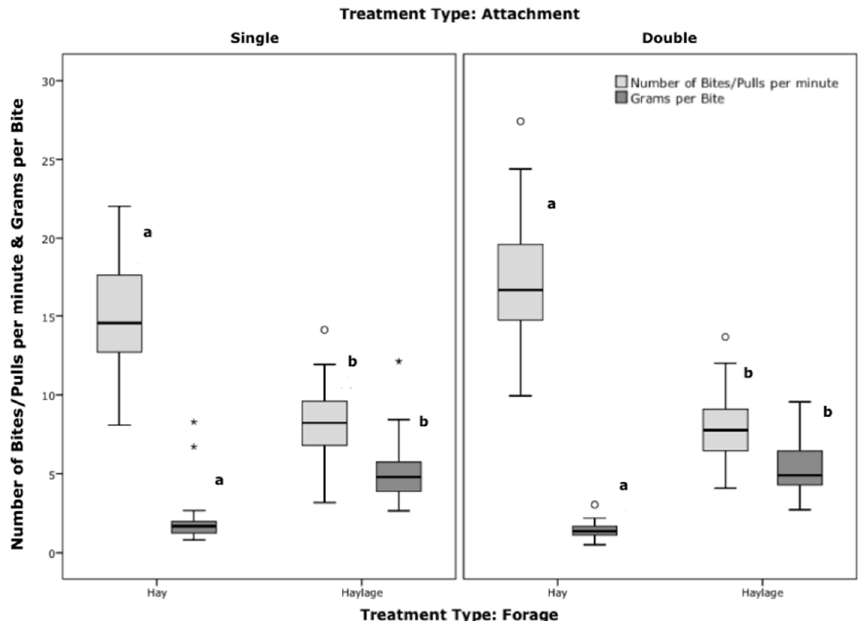
Figure 9. Distributions of number of bites (pulls)/minute (light grey) and grams/ bite (dark grey), grouped by attachment and forage type. Boxplots between forage treatments that do not share lower case superscripts differ significantly ( p < 0.001, Anova). Boxplots between attachment types but same forage did not show significant differences (*, o = outliers).